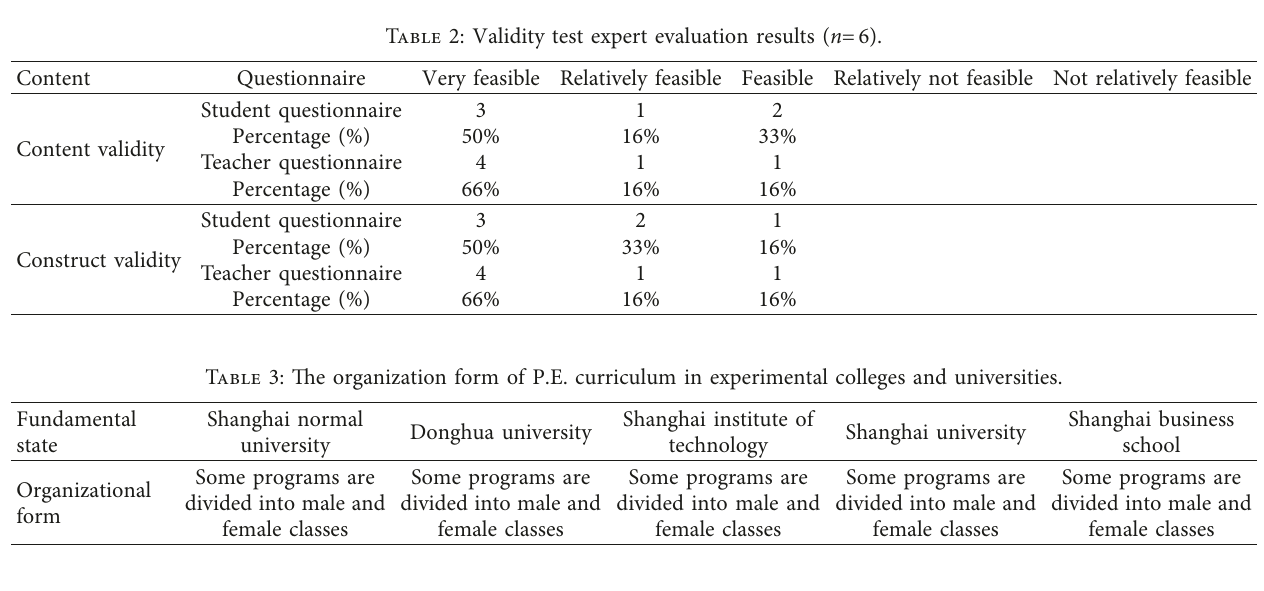
Table 4: The stratified teaching situation of PE course in pilot colleges and universities.